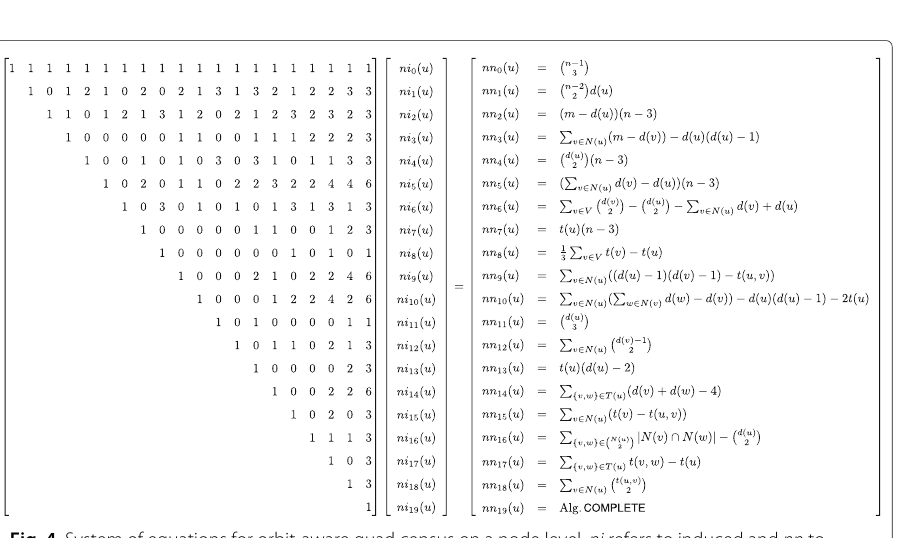
that even if a neighbor of either v or w is a neighbor of u as well there is no additional paw (cid:4) ( d ( v ) + d ( w ) − 4 ) . with u in orbit 14 and therefore nn 14 ( u ) = { v , w }∈ T ( u ) Non-induced orbit 4 edge census. Edge e = { u , v } is non-induced in orbit 4 for each P 3 starting at u or v which neither contains e nor closes a K 3 with e . The number of P 3 s (cid:4) ( d ( w ) − 1 ) . However, the node v might be a starting at u not containing e equals w ∈ N ( u ) \ v neighbor of w and therefore there is a path of length two (via w ) connecting u and v . Since this creates a three-node subgraph, more precisely a triangle, and not a quad we have to adjust for this by subtracting twice the number of triangles containing e . Consequently, (cid:4) (cid:4) d ( w ) + d ( w ) − 2 ( d ( u ) + d ( v )) + 2 − 2 t ( u , v ) . en 4 ( u , v ) = w ∈ N ( u ) w ∈ N ( v )